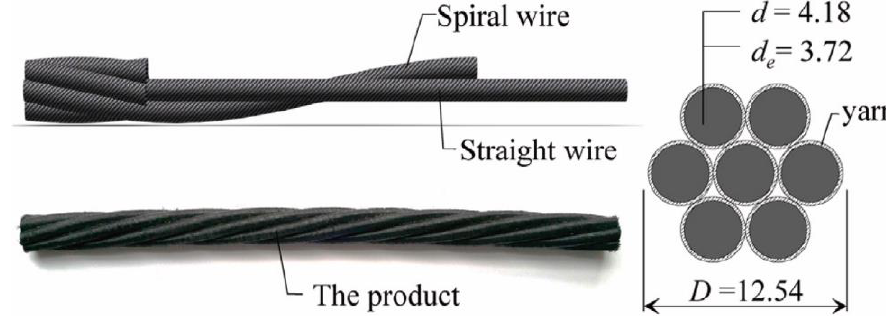
Figure 2. Details of CFRP tendons.